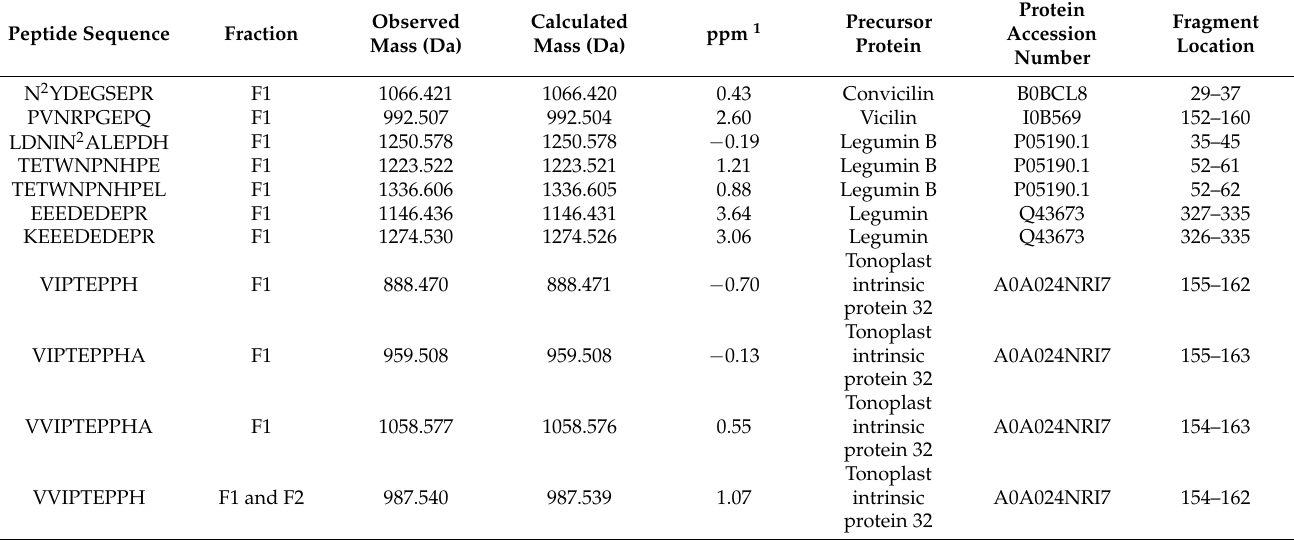
Table 4. LC-MS/MS identified faba bean peptides and their respective precursor proteins found in the peptide-enriched fractions of the 3 kDa permeate of Fabelle in vitro gastrointestinal